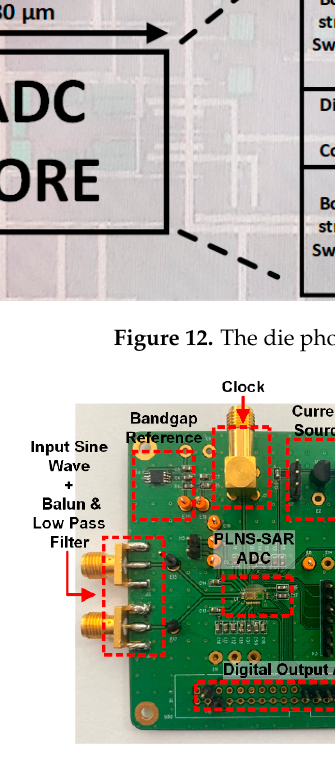
Figure 13. The evaluation board for the proposed ADC prototype.